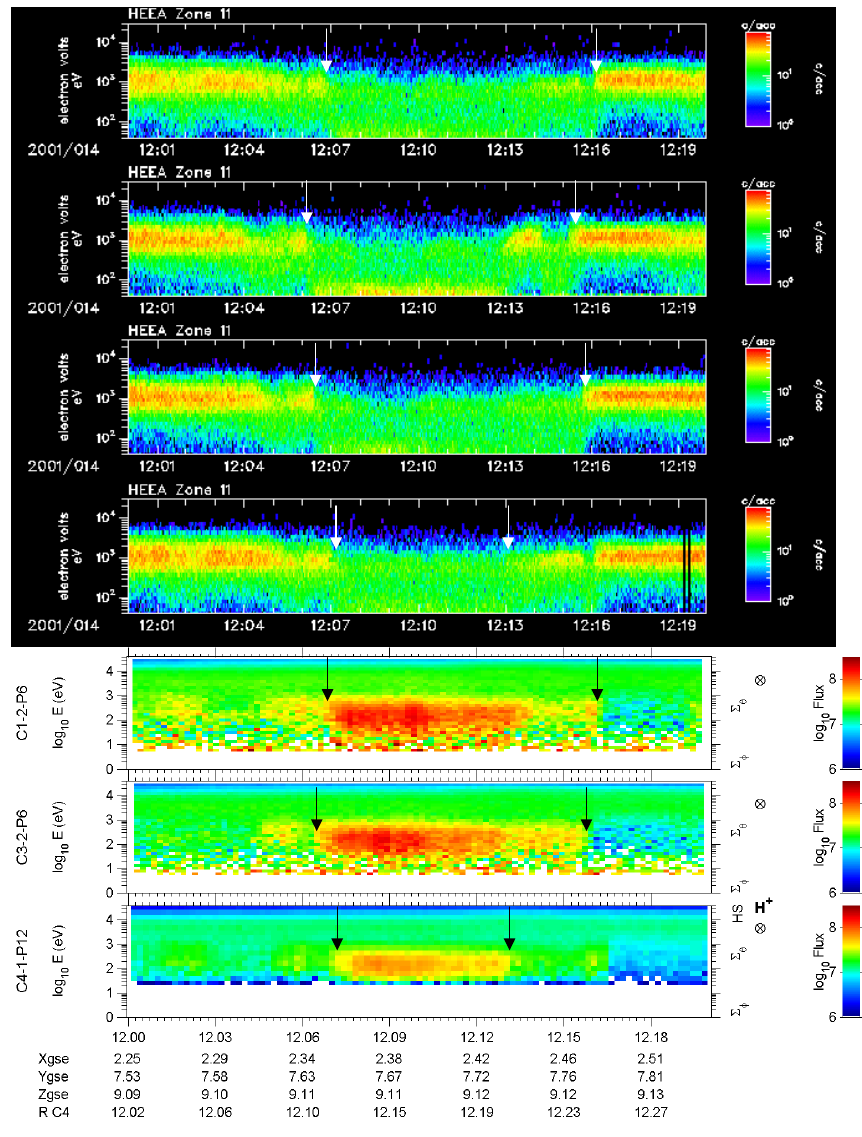
Fig. 12. Same as Fig. 8 for the interval